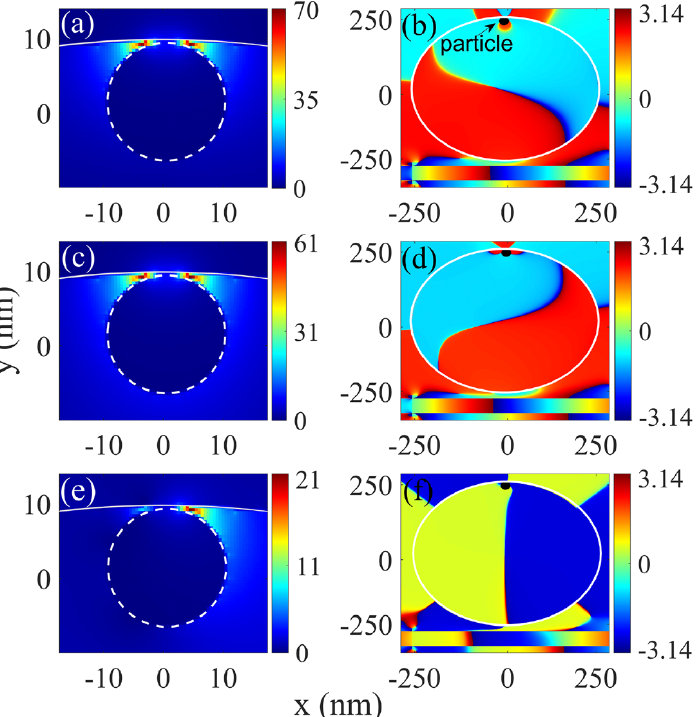
Figure 4. The near-field module around the particle and the E y phase distributions in whole cavity at resonances with r 2 = 10.0 nm. Dip NM 1 centered at 589.8 nm, as well as ( a ) | E | and ( b ) E y phases. Dip NM 2 centered at 622.2 nm, as well as ( c ) | E | and ( d ) E y phases. Dip 3 centered at 606.8 nm, as well as ( e ) | E | and ( f ) E y phases. According to the superposition principle, dips 2 and 3 became antisymmetric modes (SPP − ) after the particle was introduced. Their near fields and E y phases became standing- wave distributions. Only the electric fields of dip 3 are shown in Figure 4e for module | E | and in Figure 4f for the E y phases in the cavity. It can be seen that the near field became weak, with the module maximum of 21.3 times the incident SPP intensity in the waveguide. The particle was located at a node, as shown in Figure 4f. Clearly, an antisymmetric mode (SPP − ) cannot couple with the LSPR in the gap between the particle and the cavity inwall. A particle deviated from the inwall of the cavity, as illustrated in Figure 5a. Transmis- sion spectra for different spaces (h) are shown in Figure 5b. The particle radius (r = 12.0 nm) remained unchanged, and dips 1, 2, and 3 were maintained. A new dip emerged near dip 2 when h < 2.0 nm. The variations in resonance modes with space (h) are shown in Figure 5c. Dip 2 began to split when h < 2.0 nm. When h ≥ 2.5 nm, the particle did not work, and LSPR could not be excited. When h < 2.0 nm, the particle worked. The LSPR between the particle and cavity inwall was excited and interacted with WGM, leading to second-order SPP WGM mode splitting. Figure 5d shows the near-field module of dip NM 3 at 466.3 nm when h = 1.0 nm. LSPR was clearly excited at the gap center. The phase distribution of E y shown in Figure 5e illustrates that a standing wave formed in the cavity and that the particle was located at an antinode. These results indicate that the LSPR at the gap center led to second-order WGM splitting into SM and ASM. Strong coupling between the second-order WGM SM and LSPR then occurred. Dip NM 3 originated from the positive strong coupling between the second-order WGM SM and LSPR. It is possible that the opposite strong coupling mode occurred outside of the considered wavelength range and therefore cannot be seen. Mode splitting was useful to sense distances below 1 nm with subnanometer